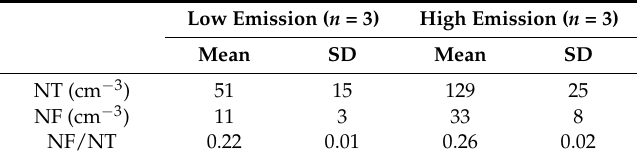
Table 4. Summary of particle concentrations measured by the SIBS (n, number of measurements; NT, Number of total Particles; NF, Number of fluorescent particles; SD, Standard